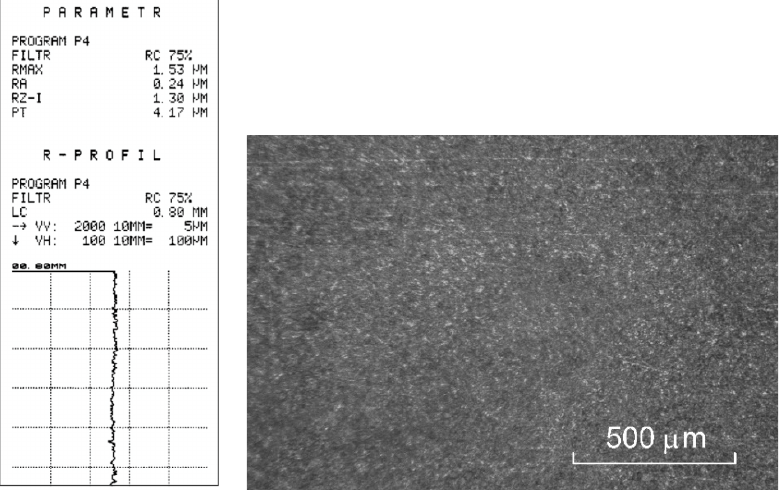
Figure 21. View of the sample surface adequately machined.